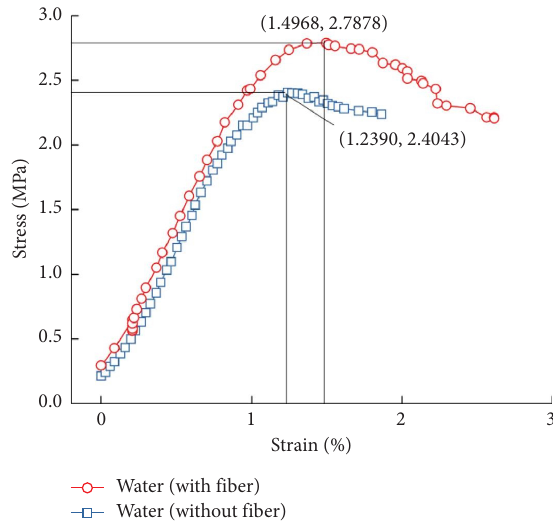
Figure 15: Te damage curve of specimens under diferent freezing-thawing cycles.